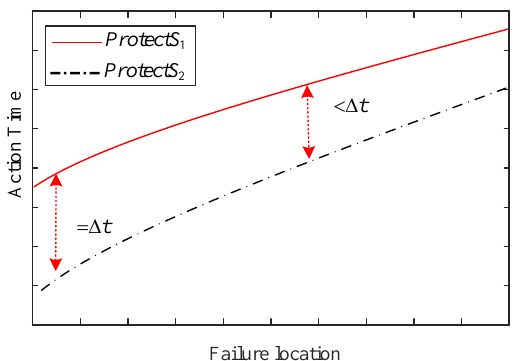
Figure 6. Schematic diagram of protection mismatch with DG.